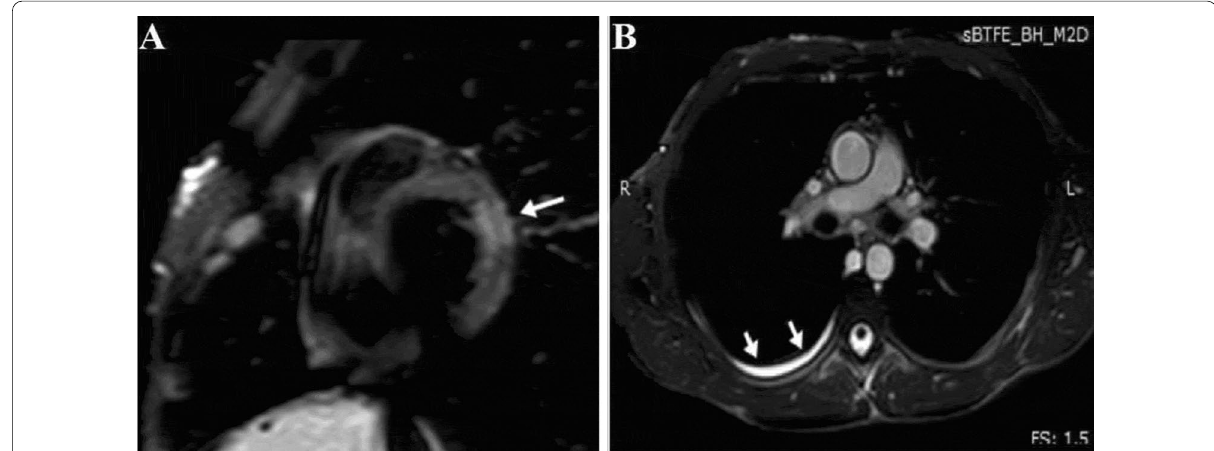
Fig. 1 Cardiac MRI of a 33-year-old male patient with Behcet’s disease with A small patchy area of myocardial edema in lateral segment of basal myocardium of left ventricle in cardiac MRI T2 edema sequence short axis view and B small right sided pleural effusion in Cardiac MRI cine SSFP axial